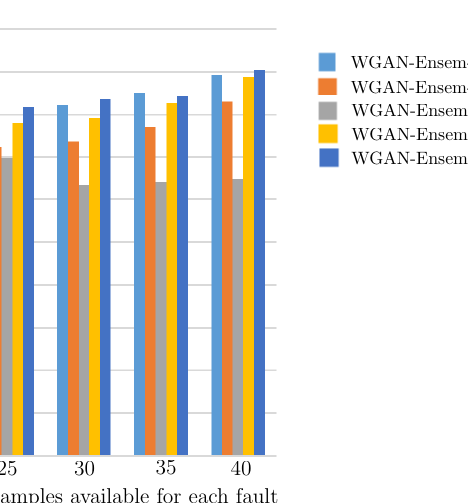
Figure 6. Classification/diagnosis results comparison between various classifiers using WGAN-ensemble to generate artificial faulty training samples. Table 6. Comparing the fault diagnosis accuracy rates (%) obtained by the proposed WGAN frameworks with the best results in